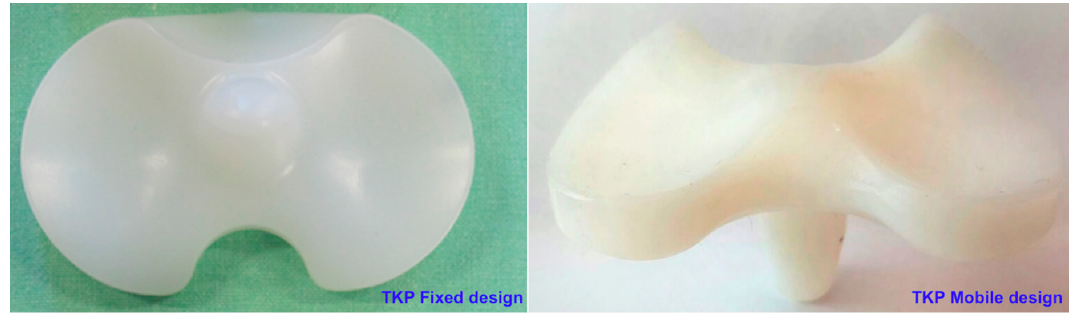
Figure 1. Total knee prosthesis (TKP) fixed and mobile design used in this study.